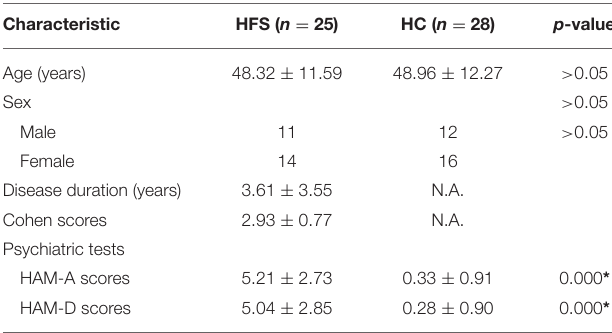
TABLE 1 | Summary of demographic characteristics and psychiatric tests between patients with HFS and healthy controls.